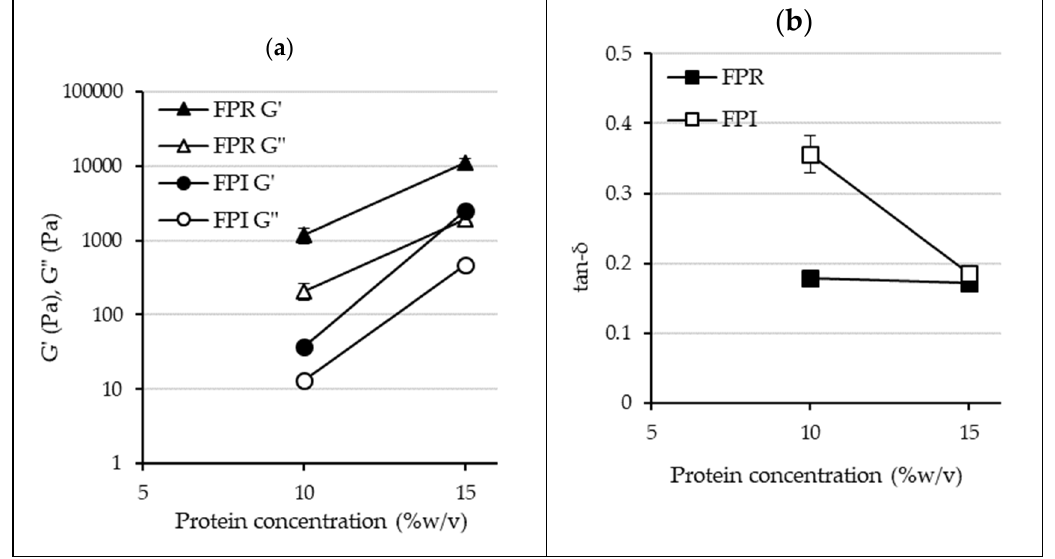
Figure 7. Final values for G’ and G” ( a ), and tan- δ ( b ) for FPR and FPI at 10% and 15% protein (error bars show standard deviation). Table 3. Gelation onset temperature (T g ), including G’>G” crossover temperature and temperature, where rate of G’ increase reaches 0.5 Pa/°C.